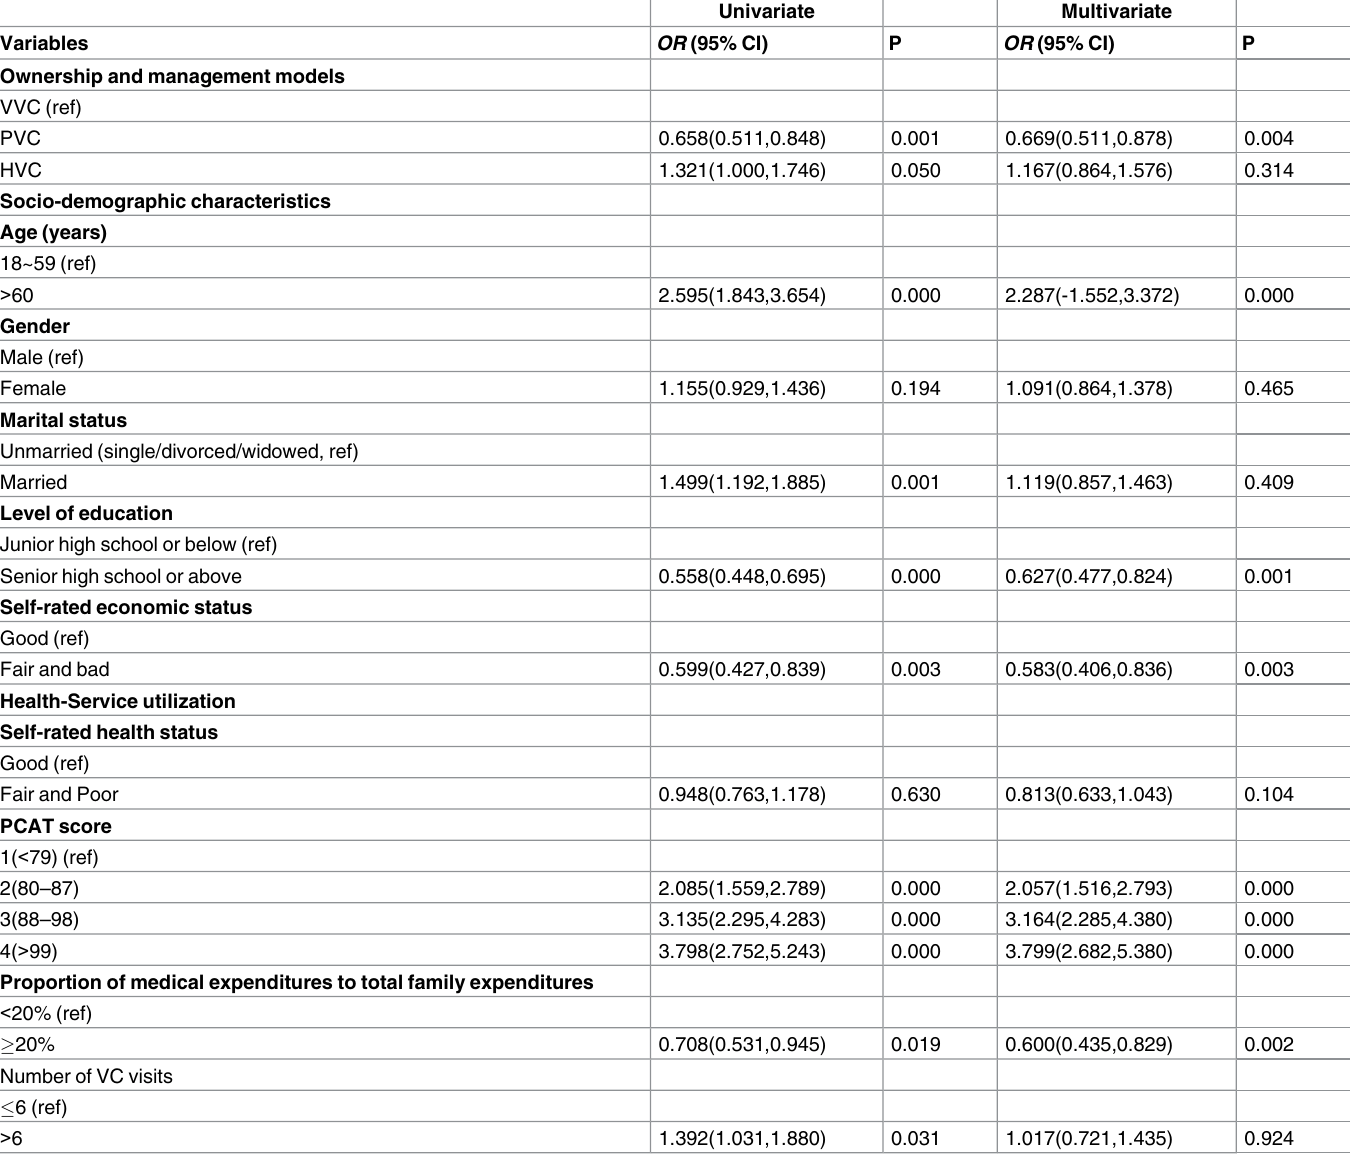
Table 5. Binary logistic regression analysis on